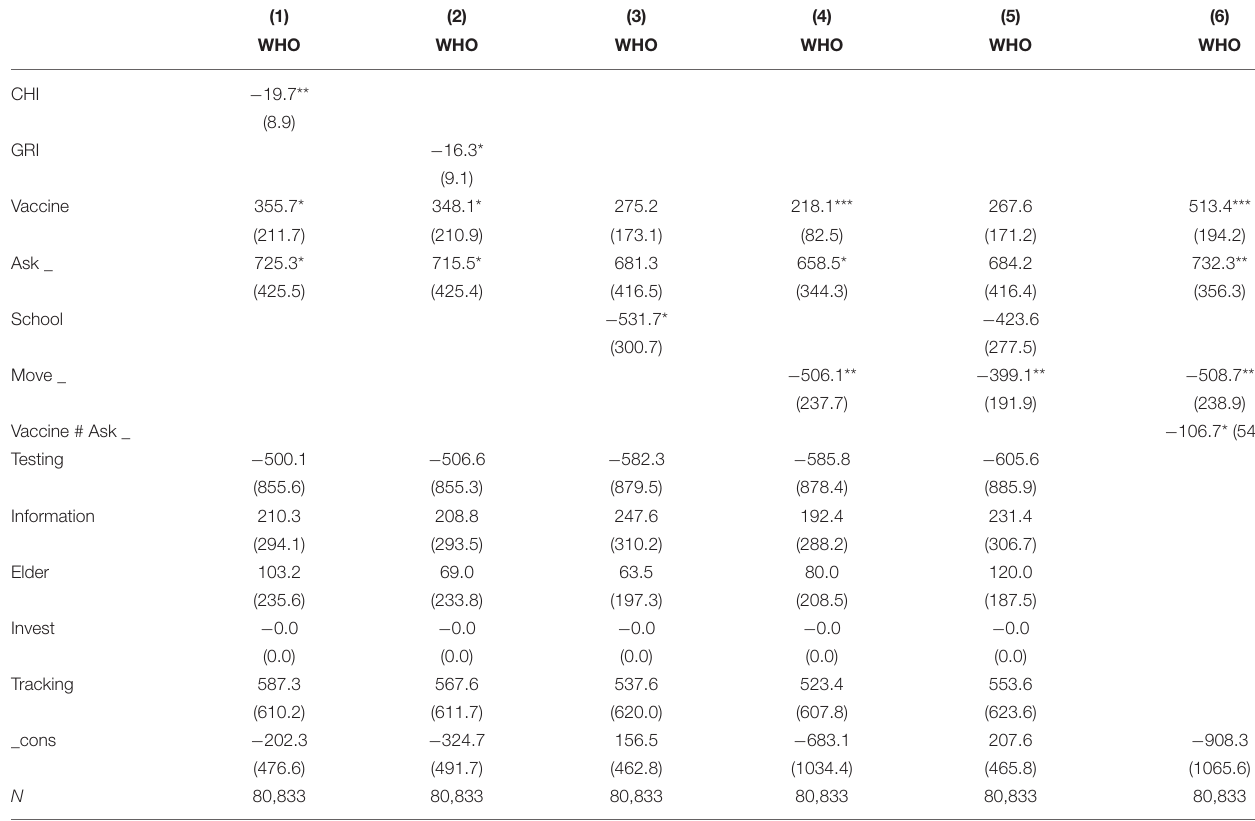
TABLE 2 | The impact of pandemic control policies on new